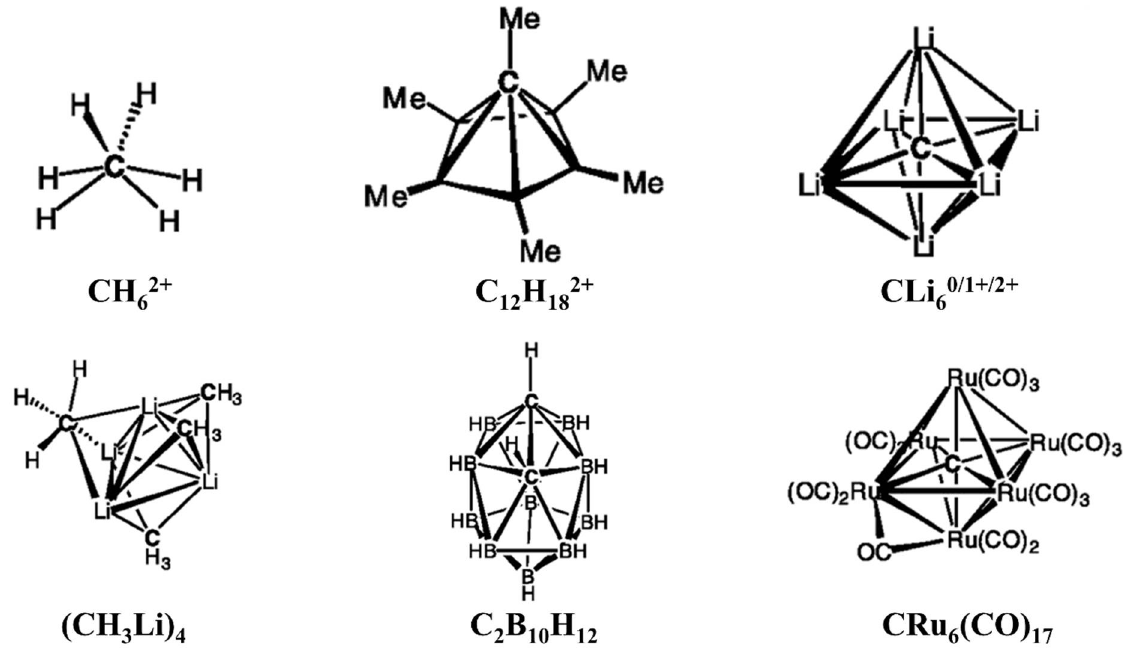
Figure 28. Some compounds with hexacoordinate carbons have three-dimensional structures.